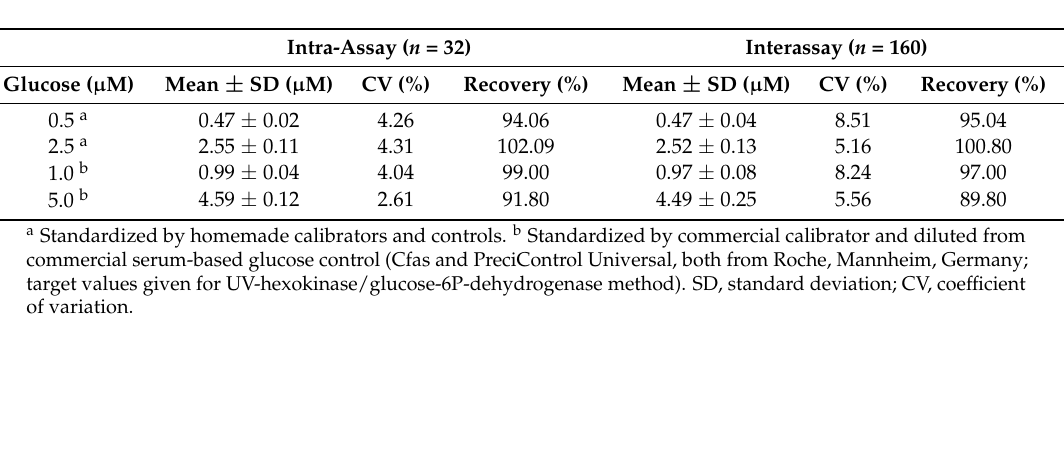
Figure 1. Example cumulative calibration curve for the glucose assay. Mean ± standard deviation (SD) data from 88 separate calibrations in the range of 0.15–10 µ M glucose are shown. With logistic model fitting, the equation of the regression line is: y = 340441.8 + (5180.88-340441.8)/(1+ ( x /12.4) 1.21 , R 2 = 0.9997. Table 1. Intra- and interassay imprecision and recovery of the glucose assay in aqueous environment using different standards/controls.